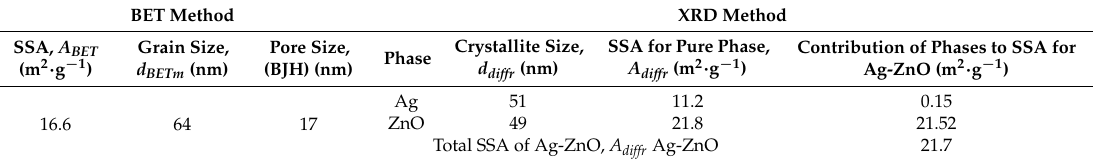
Table 1. Summary of XRD and BET analyses of Ag-ZnO. SSA stands for Specific surface area. BET